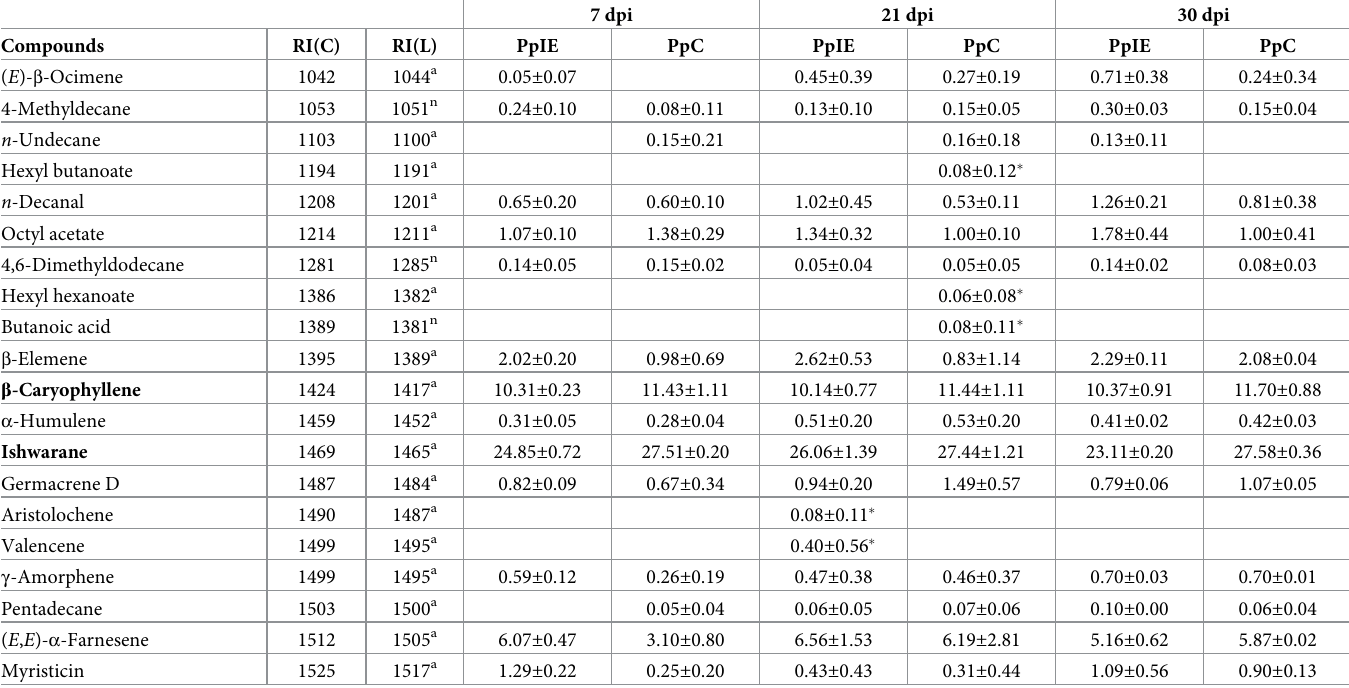
Table 3. Comparison of volatile compounds produced in leaves of Peperomia pellucida inoculated and non-inoculated with Enterobacter asburiae